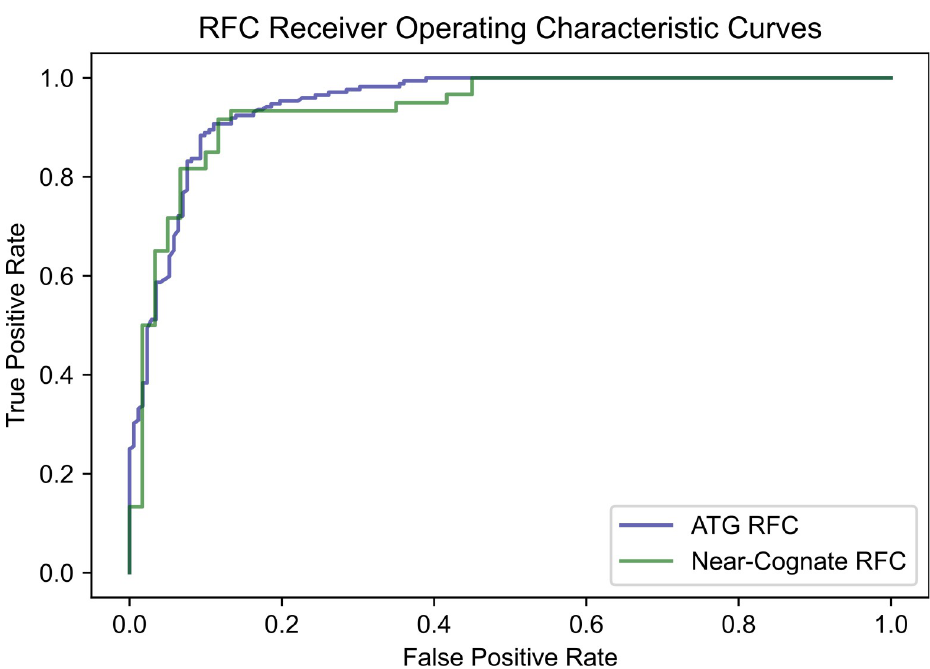
Fig 7. ROC curves of the ATG and near-cognate random forest classifiers. The AUROC score (area under the curve) of the ATG RFC is equal to 0.95. The AUROC score of the near-cognate RFC is equal to 0.94.